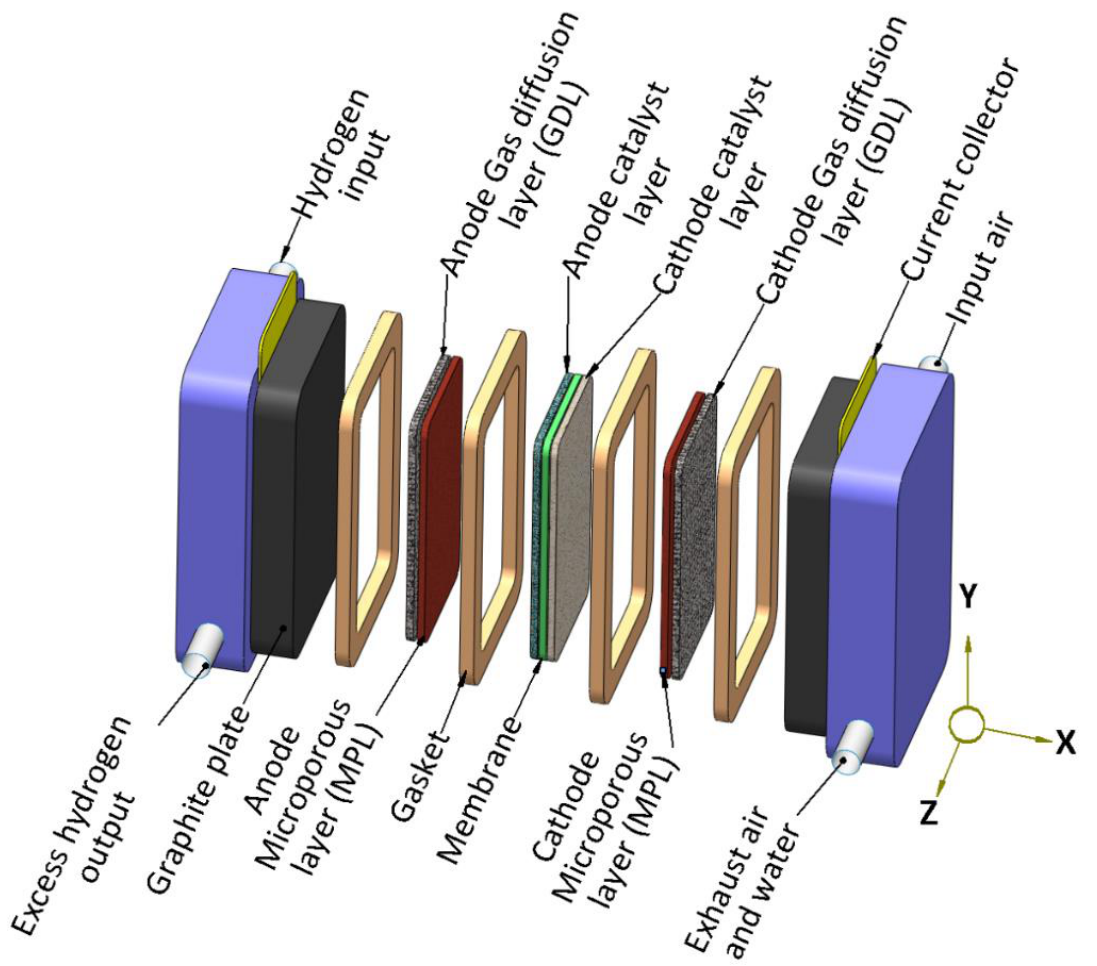
Figure 1. Schematic of a PEMFC with all the required layers in a cell [8].